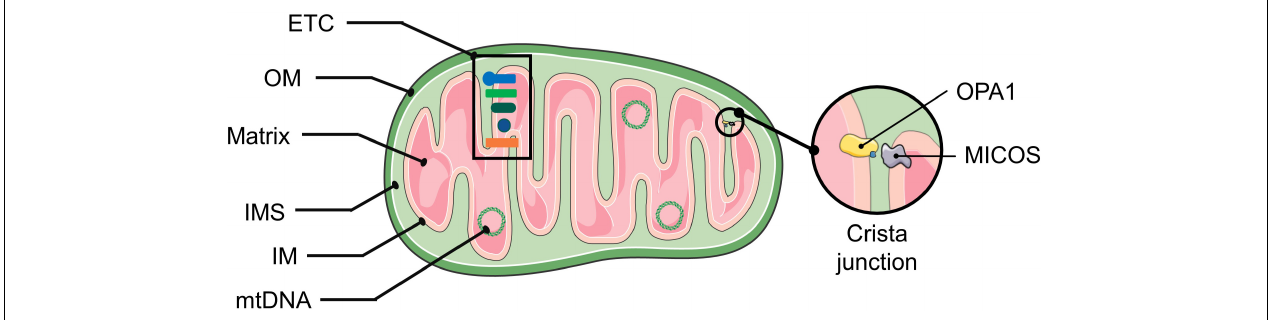
FIGURE 1 | The structure of mitochondria. The mitochondrial double membrane is a tubular reticulum, including an outer membrane (OM) and inner membrane (IM). The OM is porous and freely permits the diffusion of molecules smaller than 5 kD. The IM is a barrier to free ion diffusion and contains several cations and metabolite transporters. The invaginations of the IM that increase the surface area are called cristae. The inner mitochondrial membrane encloses the mitochondrial matrix. An intermembrane space (IMS) exists between the OM and IM, and its composition is close to that of the cytoplasmic matrix. The crista junction represents the architecture by which the cristae are attached to the inner membrane via narrow stems (Panek et al., 2020). The MICOS complex and OPA1 are involved in shaping the cristae. OPA1 act as a tether that maintains “tight” junctions to sequester cytochrome c and oxidative-phosphorylation protein complexes within the crista